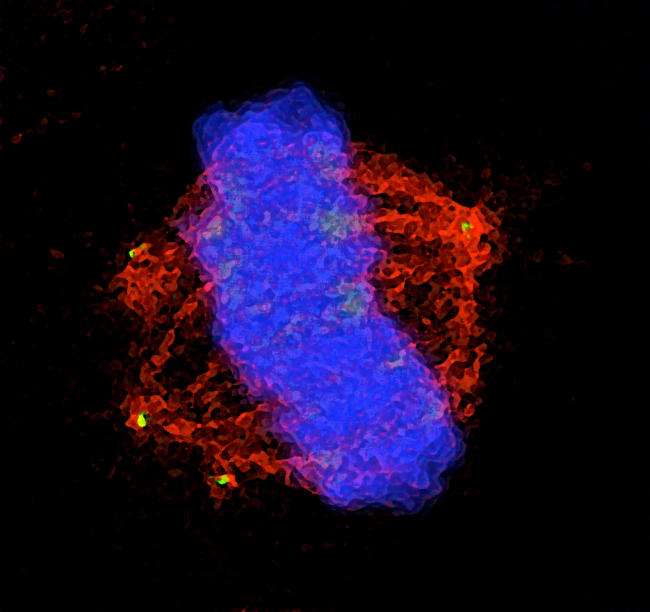
Loss of p16INK4a allows cells to produce too many centrosomes (the green dots) which in turn leads to genomic instability.